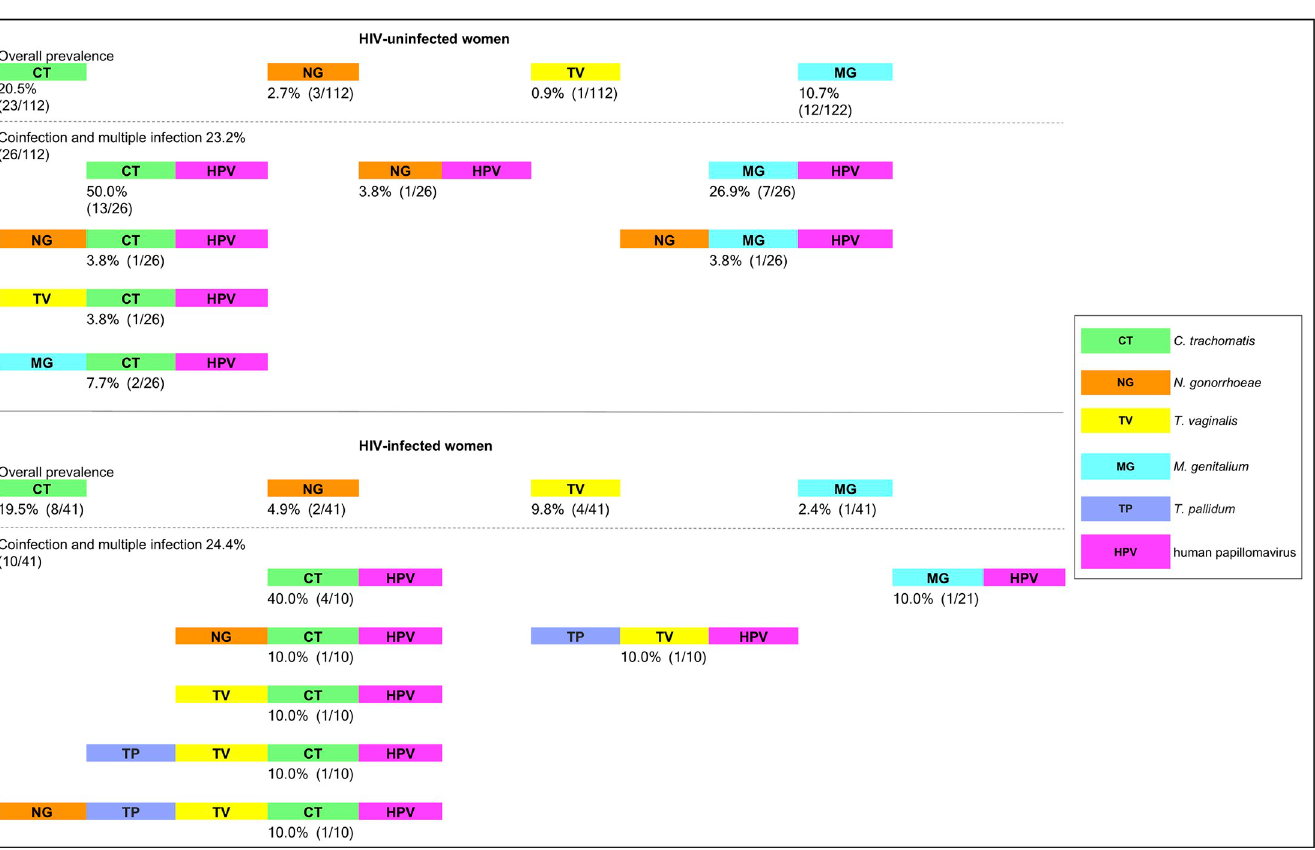
Fig 3. Overall prevalence of each STI and the percentage of coinfection and multiple infection. Coinfection is defined as a sample testing positive for two different microorganisms, for example, CT and HPV, while multiple infection is defined as a sample testing positive for three or more different microorganisms, for example, NG and CT and HPV. The number of HPV types was not used to define either coinfection or multiple